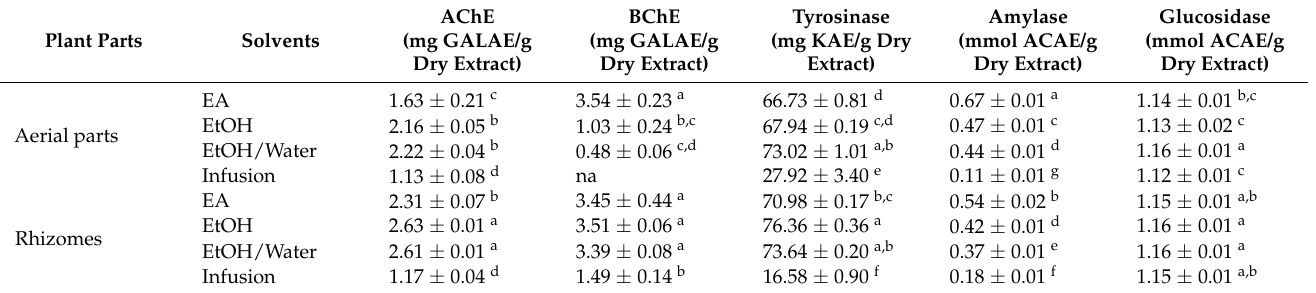
Table 4. Cholinesterases (acetylcholinesterase (AChE) and butyrlcholinesterase (BChE)), tyrosinase, amylase, and glucosidase inhibitory effects of the tested extracts